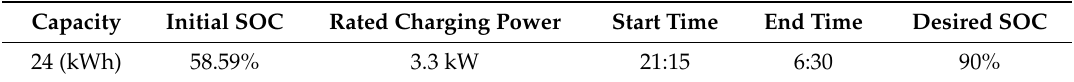
Table 3. Parameters for the fleet with 100 EVs.